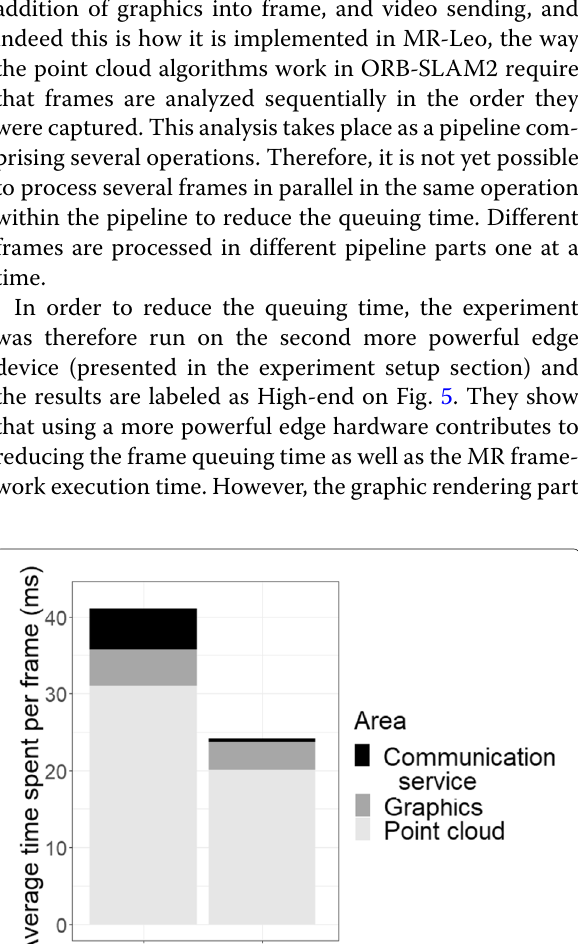
measurement study was the need for other alternatives for decreasing the time spent in the transmission part of the application (e.g. 5G transmission). An alternative to replace TCP is UDP. The FRTT results are shown in Fig. 4b. Using this protocol improved the FRTT at the 90th percentile by 27% (392 ms instead of 538). However, this comes at the cost of higher band- width required for the communication link and the MR framework has to tolerate potential loss of frames.